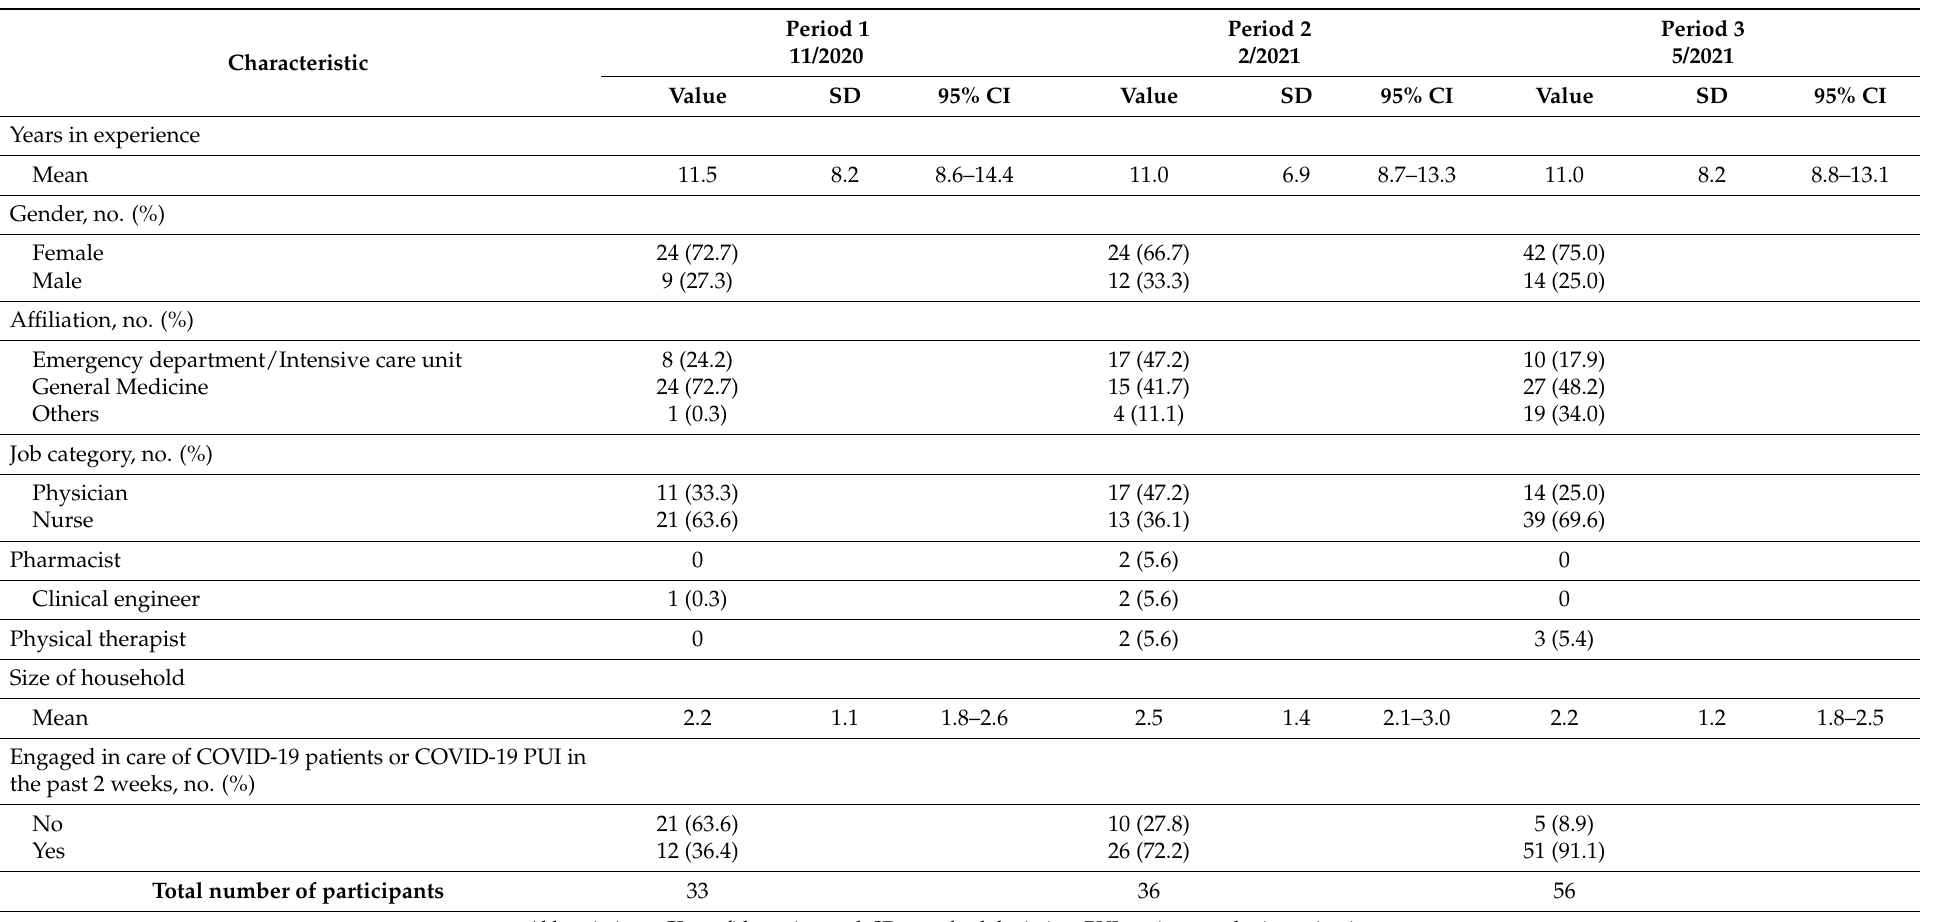
Table 1. Demographic characteristics of the study